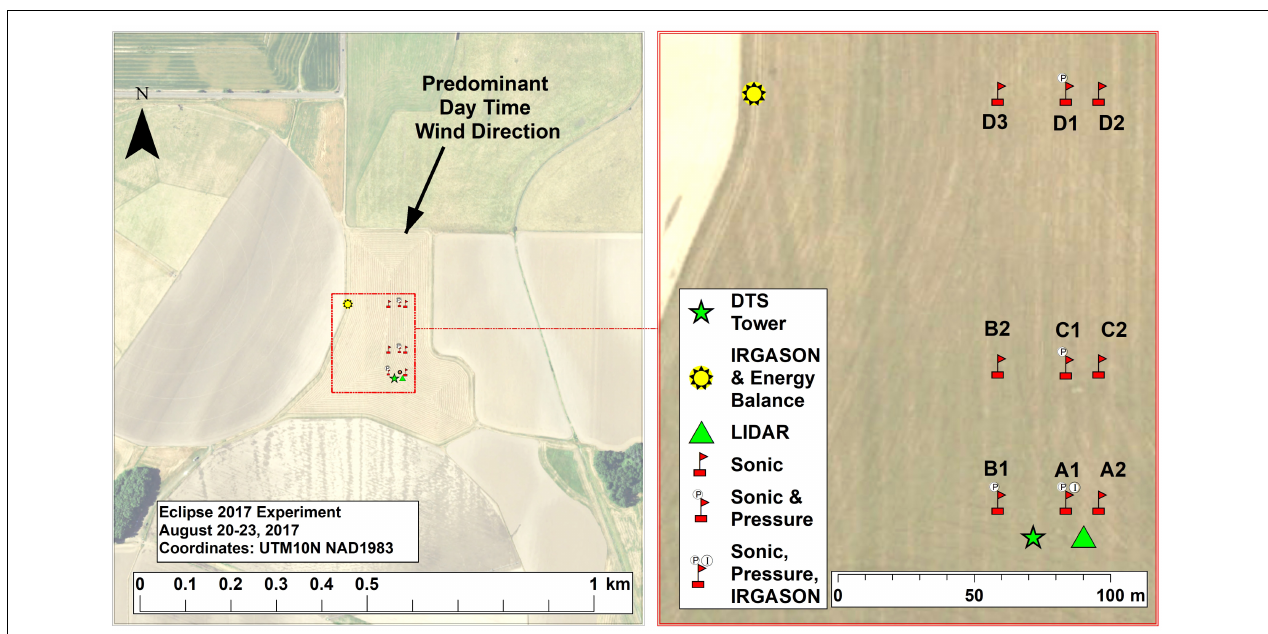
FIGURE 1 | Map and diagram of the experimental layout showing the positions of the instrumentation. The array covered an area of 0.6 ha.